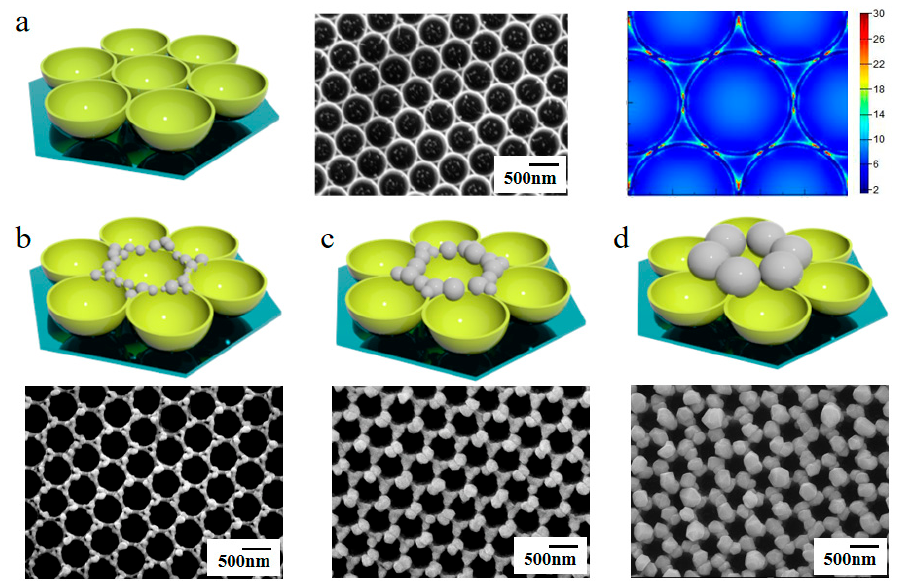
Figure 7. ( a ) SEM image and the distribution of hotspots for the Au nanobowl arrays. ( b – d ) SEM images of the Au nanobowl arrays with Ag nanoparticles (AgNPs) accurately grown at the defined hotspot location. Reproduced from [13] with permission from AIP Publishing, 2019.